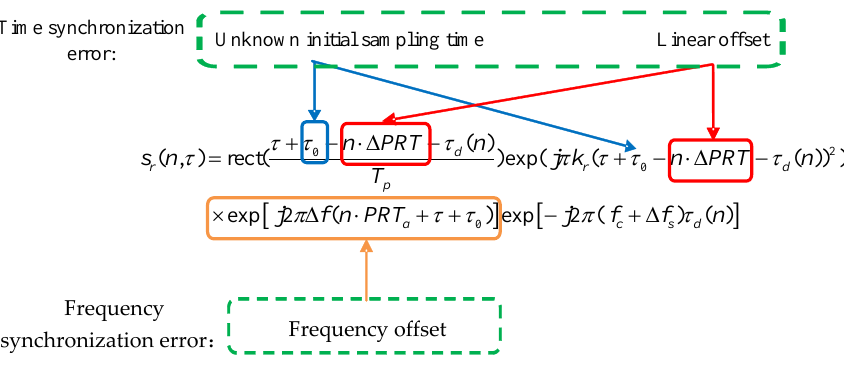
Figure 6. The expression of the synchronization error.